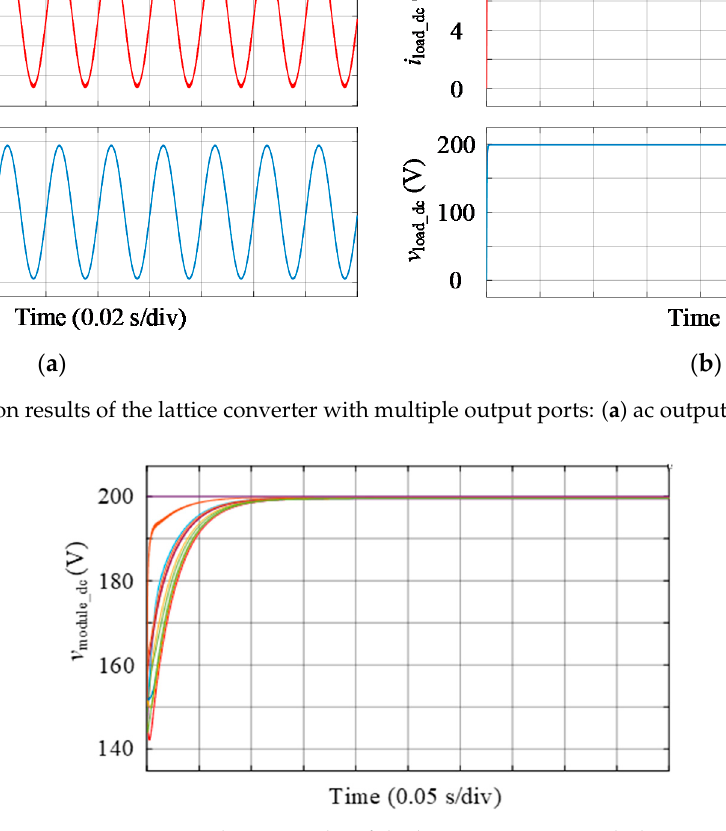
Figure 15. Simulation results of the lattice converter with dynamic voltage balancing.